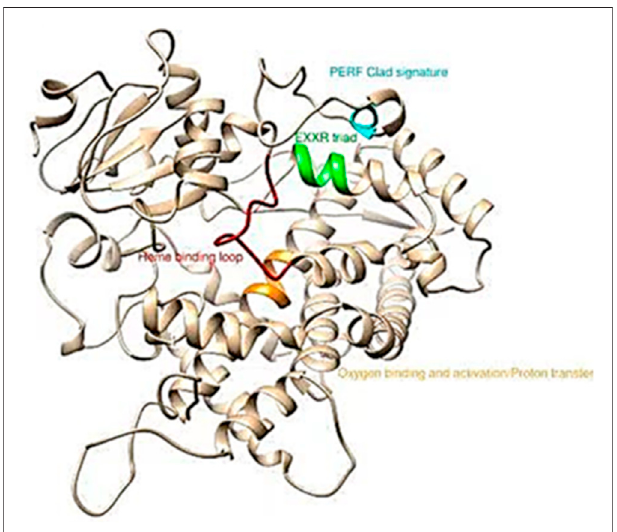
FIGURE 4 | Conserved motifs in S. frugiperda CYP6AE43 and CYP321A7 .Theproteinsequenceswerequeriedagainstthepdbdatabaseto fi nd template in ncbi